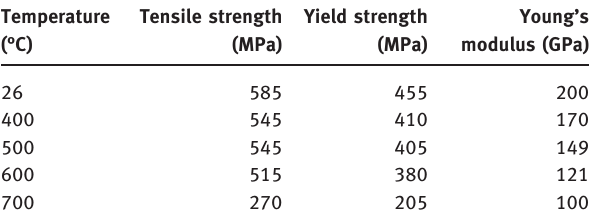
Table 2: Mechanical properties of SA302Gr.C.